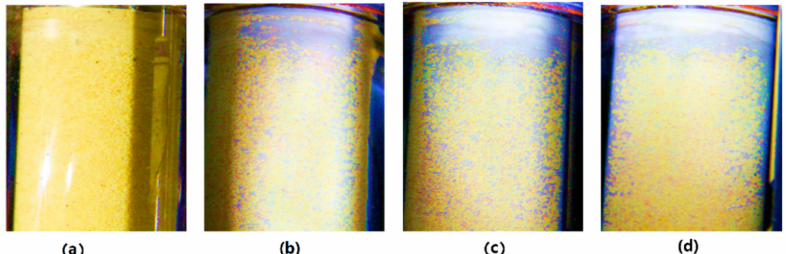
Figure 6. Hydrate morphologies in sediments of segment I: ( a ) thin hydrate film gradually emerged on inner walls of sapphire tube; ( b ) formed hydrates presented as turbid colloidal solution accumulated in top part of sapphire tube; ( c ) massive solid hydrates filled up pore space; ( d ) dispersed hydrates vanished in pore